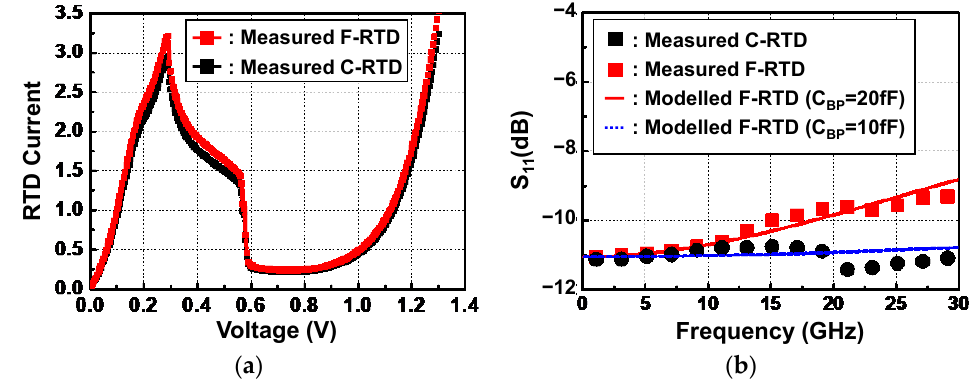
Figure 13. Measurement results of conventional InP resonant tunneling diode (C-RTD) and flip-chip-bonded InP-to-SiC resonant tunneling diodes (F-RTD): ( a ) DC I–V curve; ( b ) S-parameter data. C BP denotes a parasitic shunt capacitance of μ-bump.